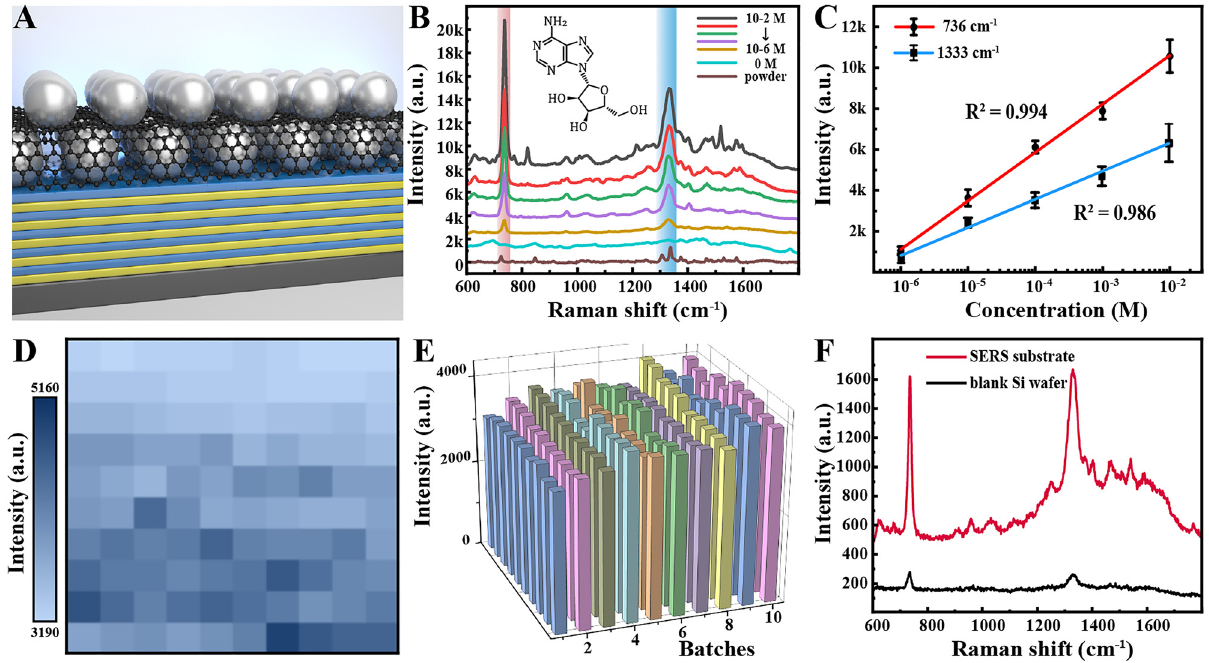
Figure 7: (A) Schematic diagram of the surface-enhanced Raman scattering (SERS) substrate. (B) Raman spectra of varying concentrations of adenosine. (C) The calibration curve of Raman intensity at different concentrations. (D) Raman mapping with an area of 20 × 20 μ m 2 for 736cm − 1 peak.(E)Theintensityof736cm − 1 peakcollectedfrom10spotsoneachof10batchesofsubstrates.(F)Ramanspectrumofadenosine (10 − 6 M) on SERS substrates and the spectrum of adenosine (10 − 2 M) on blank Si